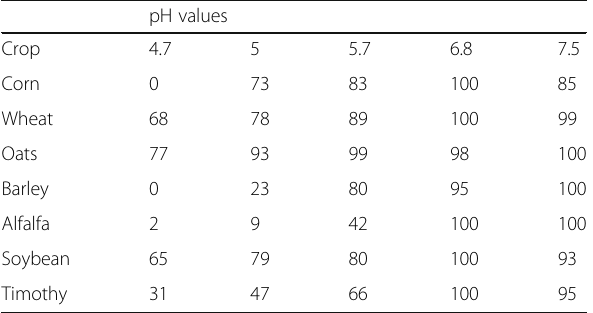
Table 3 Relative yield of selected crops grown in a corn, small grain, legumes, or timothy rotation at different pH levels (USDA